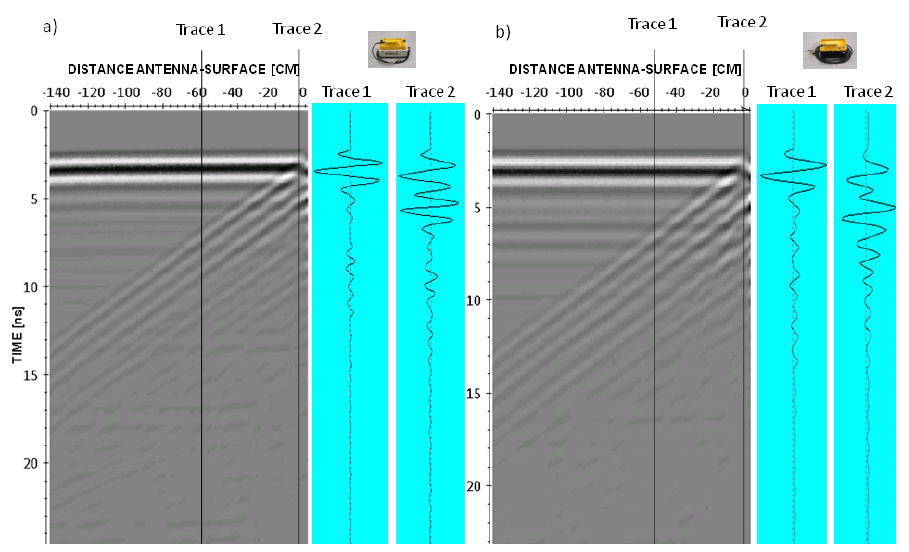
Figure 12 . Example of time zero tests carried out following the methodology of Figure 5(c) over a typical brick wall of thickness 12 cm and wave velocity 11 cm/ns: (a) 800 MHz. (b) 1